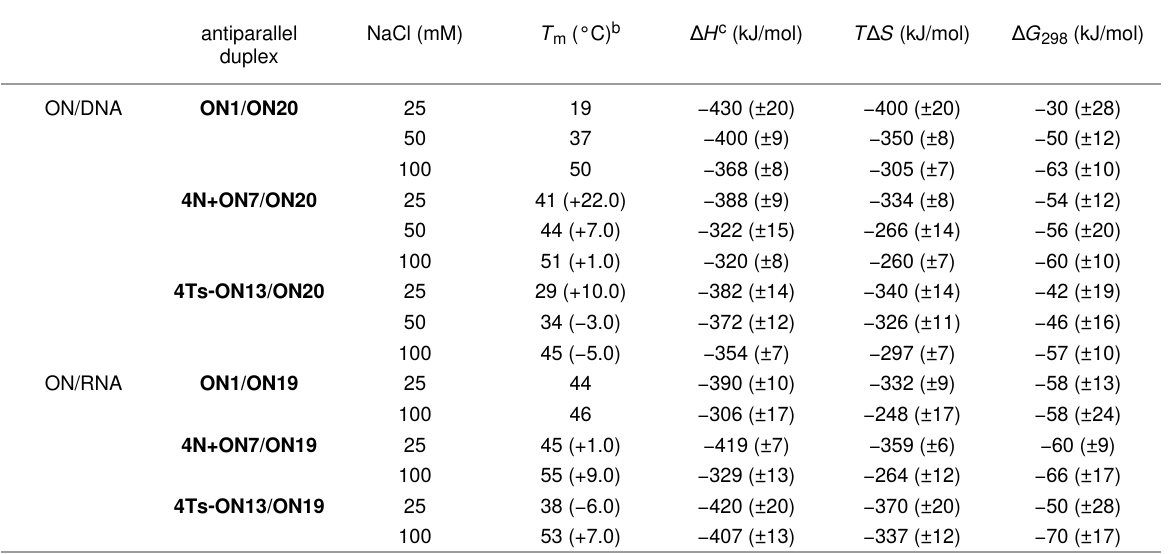
antiparallel duplex